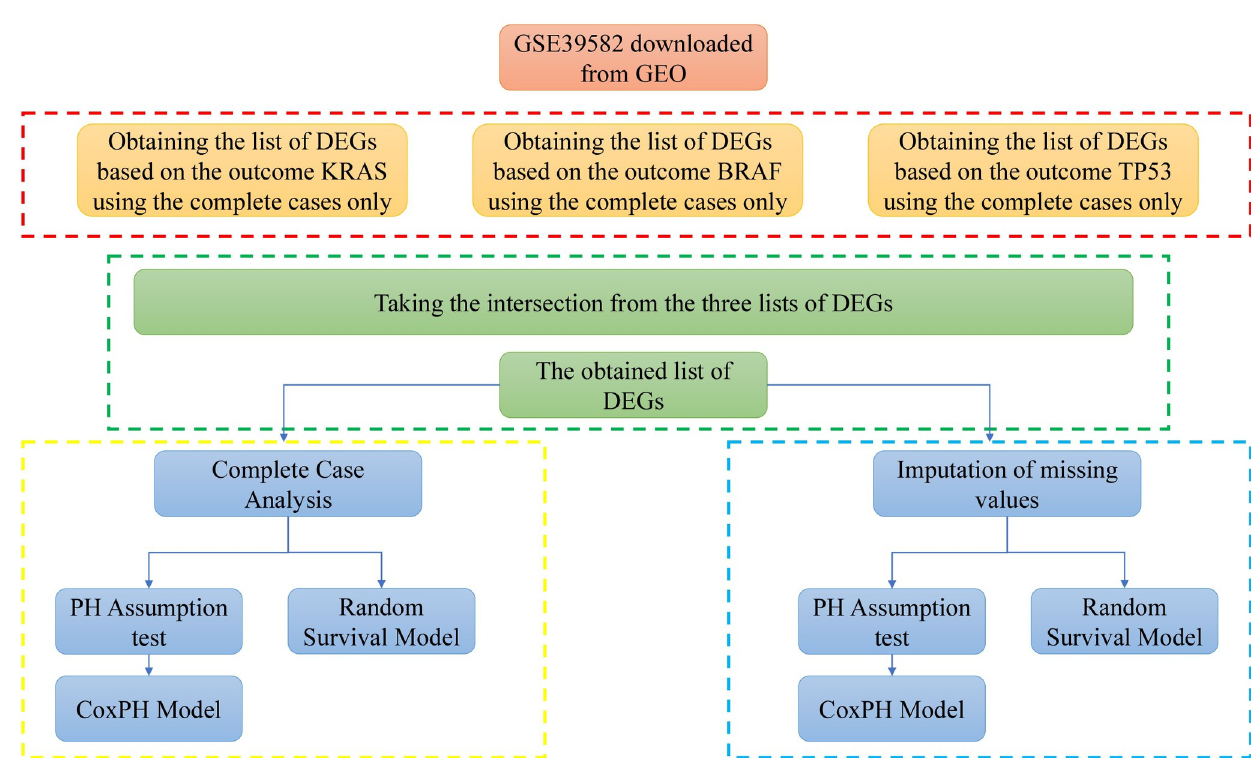
Fig 1. Flow-chart of the procedure followed in the pre-processing and analysis of the dataset.